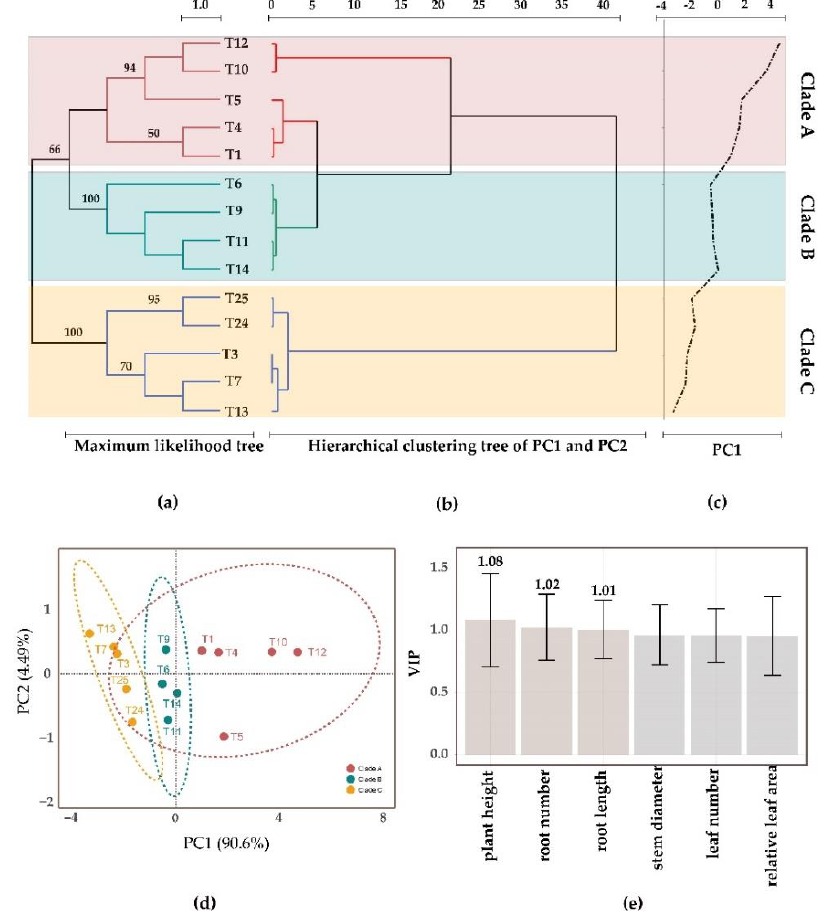
Figure 8. PCA and OPLS-DA of different fungal symbionts. ( a ) Maximum likelihood trees of ITS sequences of Tulasnella sp.; ( b ) Hierarchical clustering analysis of six morphological parameters; ( c ) PC1 analysis in a line plot; ( d ) Principal component analysis of two principal components (PC1 and PC2); ( e ) VIP values of six parameters in orthogonal partial least squares-discriminant